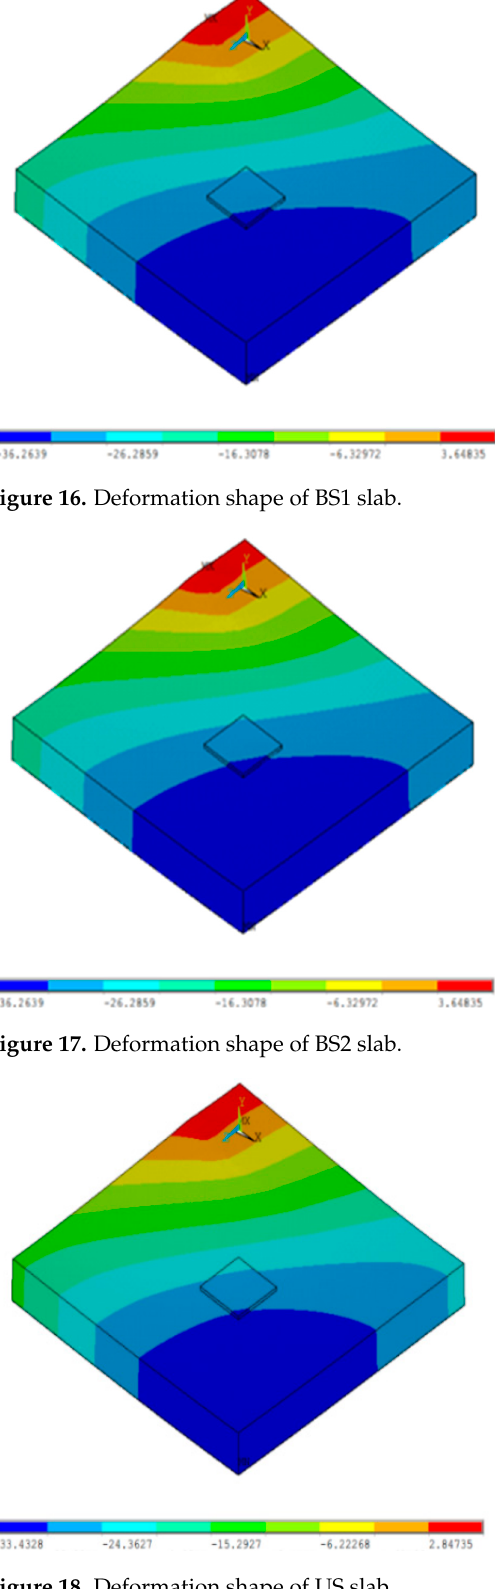
Figure 18. Deformation shape of US slab.